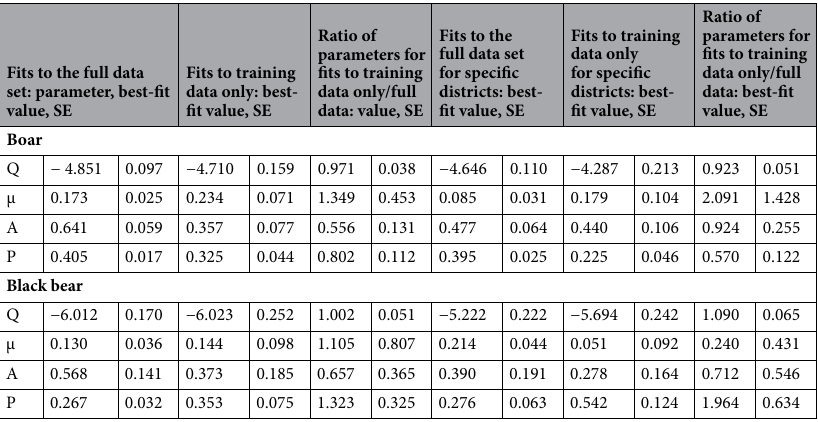
Table 2. Parameter values for fitting our model (Eq. 1A, 1B) by robust regression to wild boar and Asian black bear data. In this and the following tables, the preferred model variant with parameter ν = 1 was used, and training data represent approximately ½ of the data set between 0 and ~ 3.5 years after the Fukushima accident, as described in the main text. SE represents standard errors. For wild boar, the two selected specific districts with high mean radioactive cesium levels were Soso and Kenpoku, and for black bear they were Kenpoku and Kenchu.